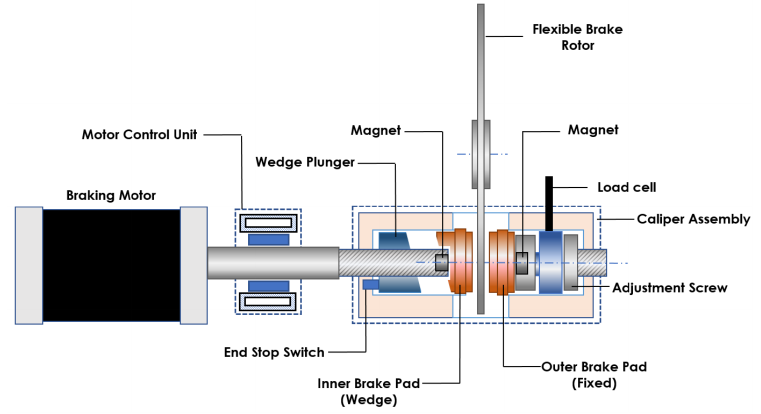
Figure 1. Configuration of the proposed EWB